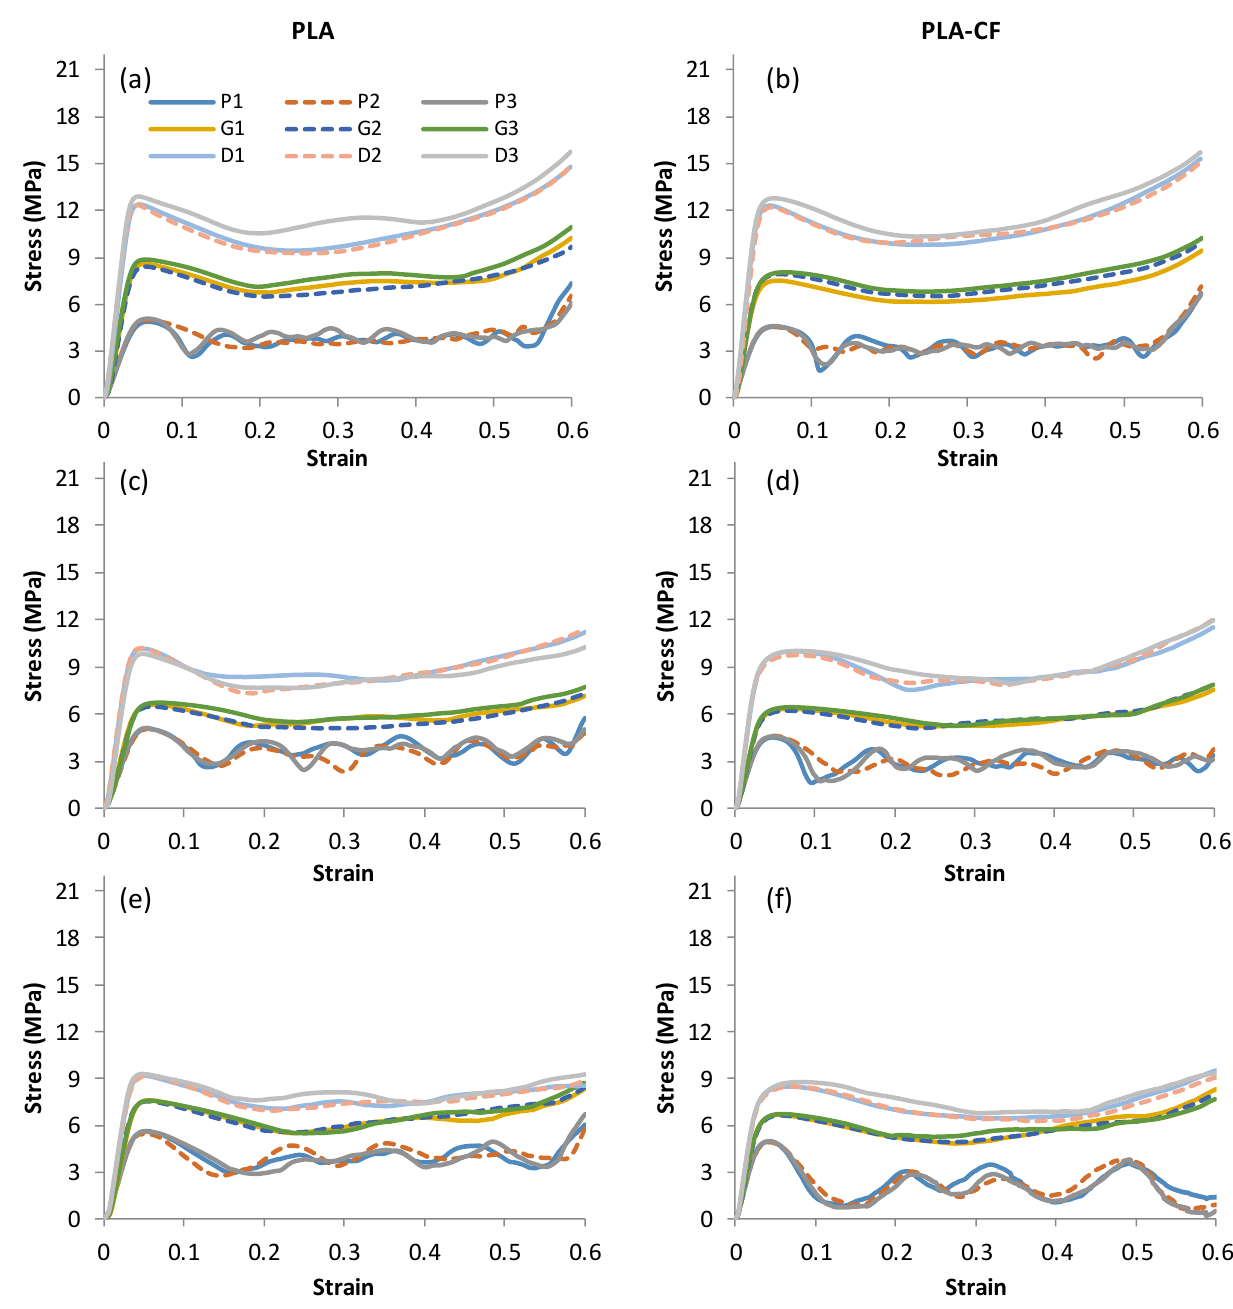
Figure 8. Stress – strain curves until 60% strain of Primitive, Gyroid, and Diamond structures at 8 mm cell size: ( a , b ) 23% RD, ( c , d ) 30% RD, ( e , f ) 37% RD, and ( g , h ) 44% RD. The red dashed boxes highlight the evident influence of CF incorporation on the plastic deformation.